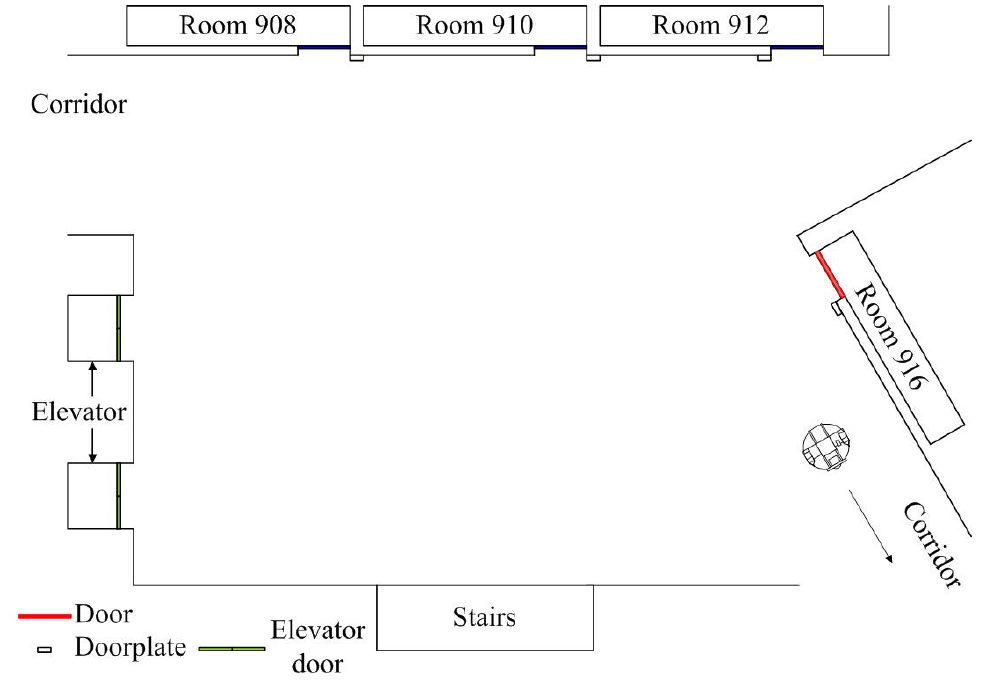
Figure 25. The second robot moves forward along the wall.